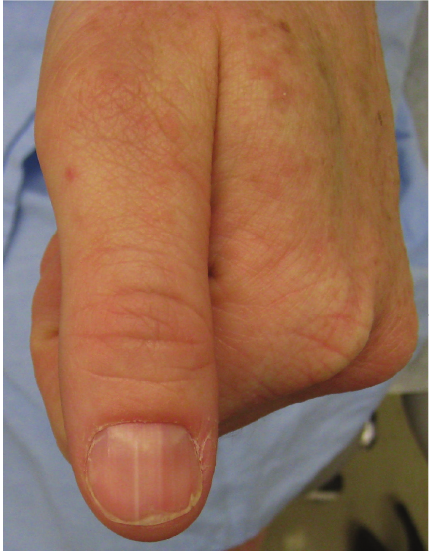
Figure 3: Left thumbnail demonstrating longitudinal erythrony- chia and distal nicking of the nail plate.